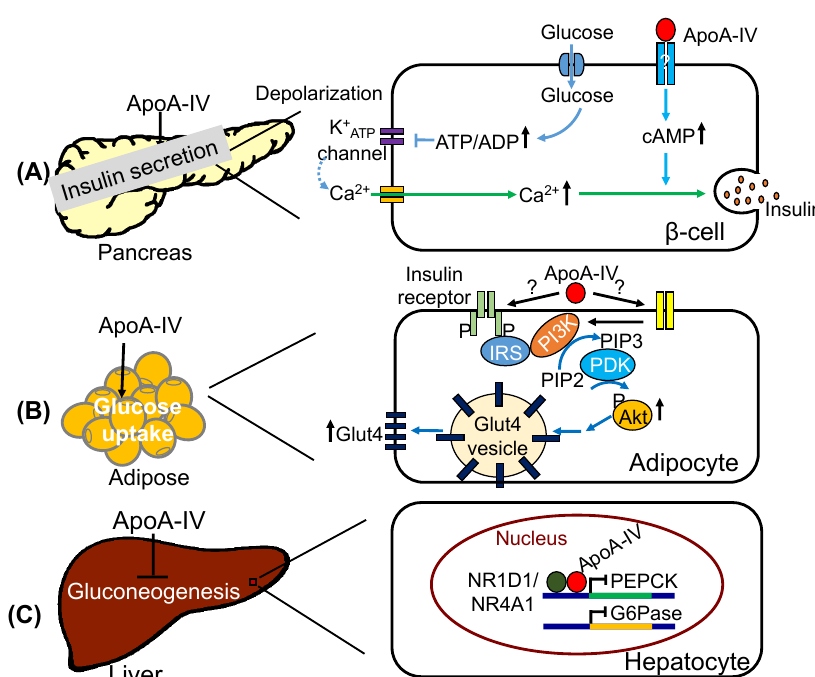
Figure 2. ApoA ‐ IV improves glucose homeostasis. ( A ) ApoA ‐ IV acts downstream of Ca 2+ ‐ dependent Figure 2. ApoA-IV improves glucose homeostasis. ( A ) ApoA-IV acts downstream of Ca 2 + -dependent insulin secretion likely via cAMP pathway. ( B ) ApoA ‐ IV activates PI3K ‐ mediated Akt insulin secretion likely via cAMP pathway. ( B ) ApoA-IV activates PI3K-mediated Akt phosphorylation phosphorylation and eventually promotes Glut4 translocation to the plasma membrane for glucose and eventually promotes Glut4 translocation to the plasma membrane for glucose uptake in adipocytes. uptake in adipocytes. ( C ) ApoA ‐ IV interacts with NR1D1 or NR4A1 in the nucleus to downregulate ( C ) ApoA-IV interacts with NR1D1 or NR4A1 in the nucleus to downregulate the expressions of PEPCK the expressions of PEPCK and G6Pase, which are involved in hepatic gluconeogenesis. and G6Pase, which are involved in hepatic gluconeogenesis.